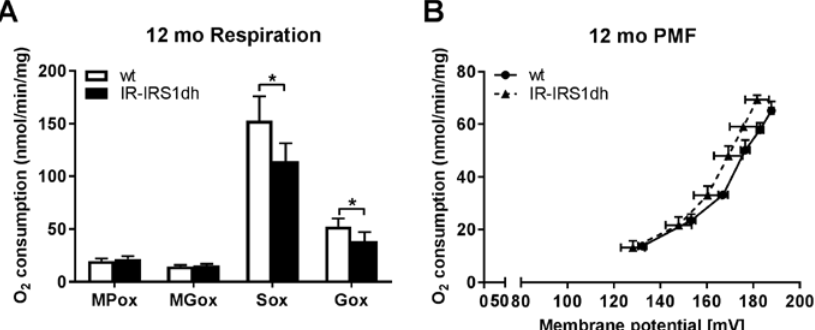
Figure 4. Liver mitochondrial performance of IR-IRS1dh mice. ( A ) Liver mitochondrial respiration determined by polarography. MPox: malate and pyruvate oxidation; MGox: malate and glutamate oxidation; Sox: succinate oxidation; Gox: glyceraldehyde 3-phosphate oxidation. Pyruvate and glutamate were used as complex I, succinate as complex II, and glyceraldehyde 3-phosphate as complex III substrates, respectively. ( B ) Liver mitochondrial proton motive force (PMF) measurements. Columns and symbols represent ( A ) mean values ± standard deviation or ( B ) mean values ± standard error; n : 5, * denotes significant differences between IR-IRS1dh mice compared to wt controls; * p <